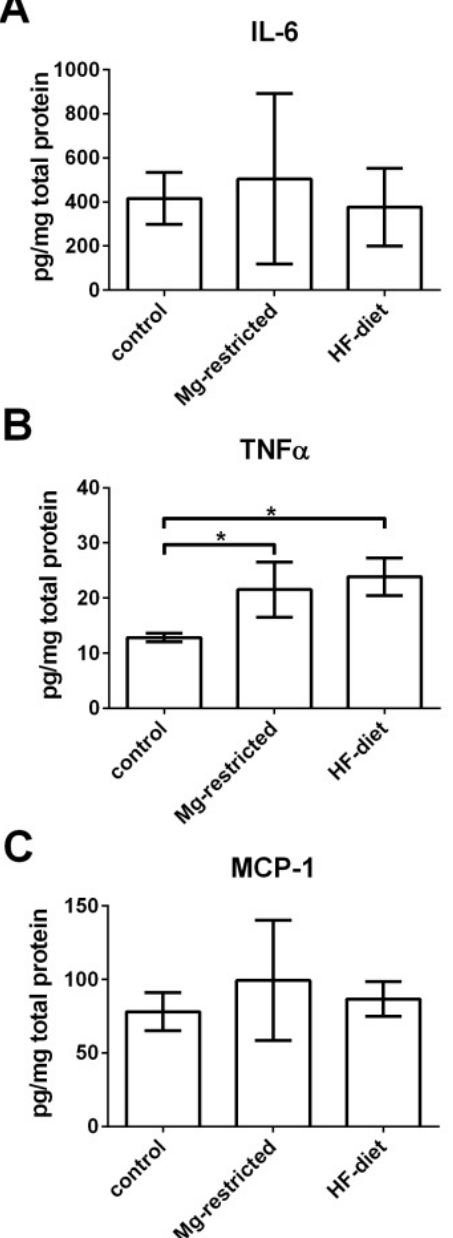
Figure 5. Influence of Mg-restriction and HF-diet feeding on hepatic inflammation. Levels of inflammation markers IL-6, TNF α , and MCP-1 were measured in liver homogenates, resulting in no significant alterations in ( A ) IL-6 and ( C ) MCP-1, while ( B ) TNF α levels are significantly increased in Mg-restricted and HF-diet fed mice compared to control mice. Shown are means with standard deviations and relevant significant differences are marked with an * ( p values of < 0.05 by one-way ANOVA followed by Dunnett’s multiple comparisons test).